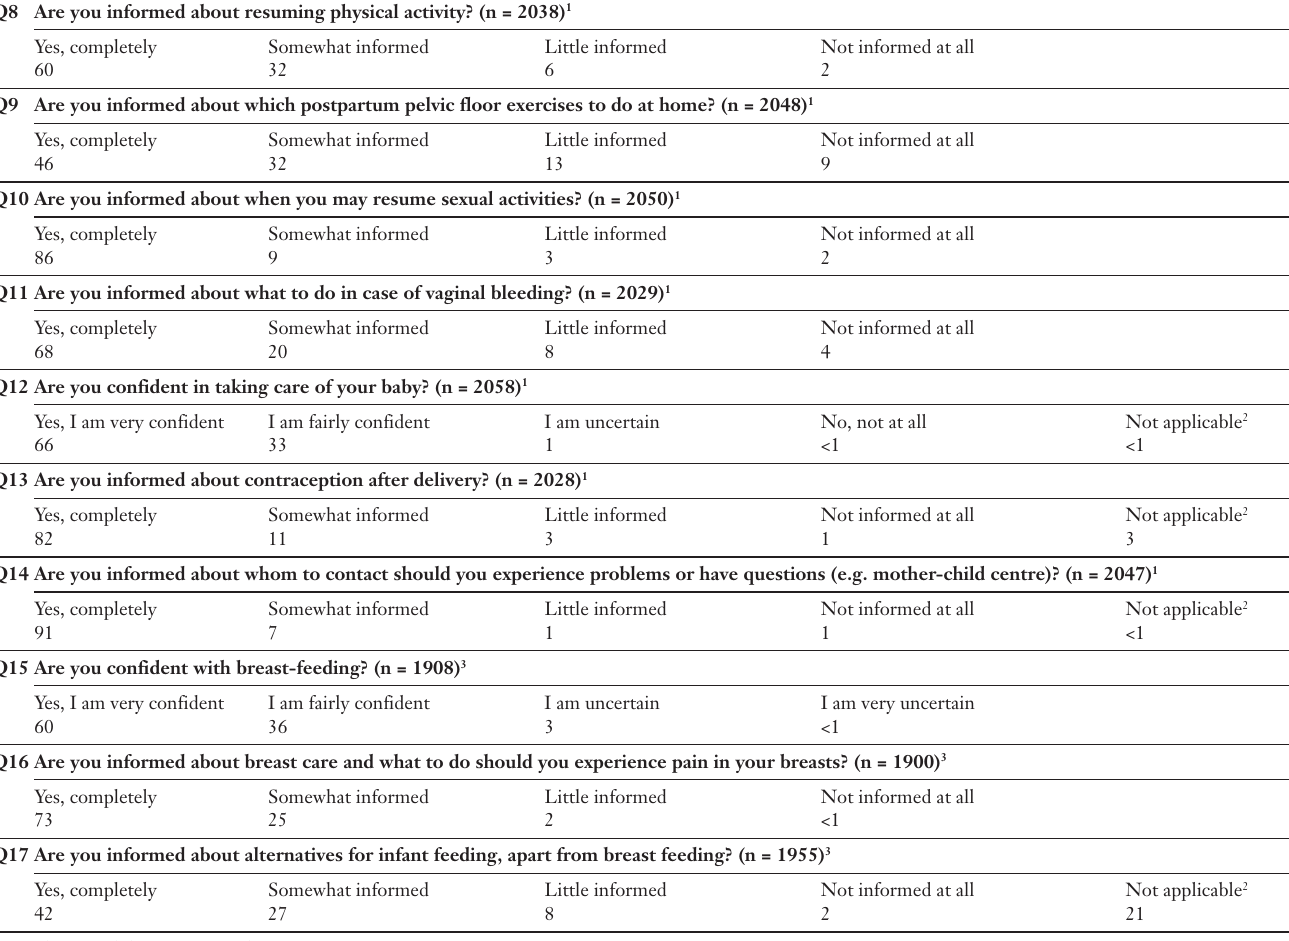
Summary of responses to individual questions unrelated to mode of delivery presented in the questionnaire. Values are percentages of patients to whom the question applied and who answered the question. Questions applying to all mothers (n =